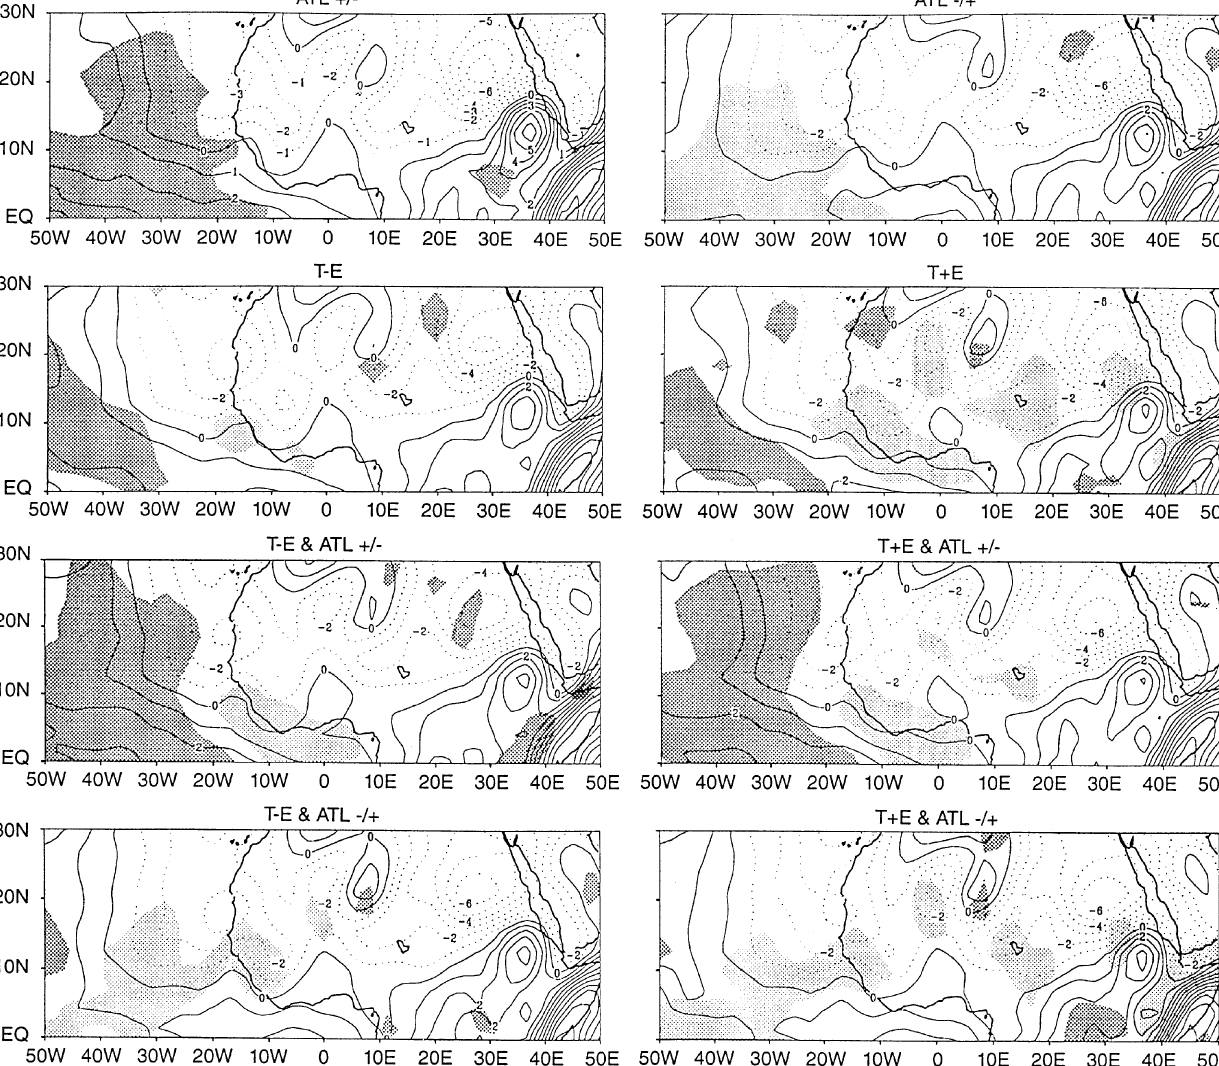
Fig. 8. Same as for Fig. 7 except for the meridional wind component at 850